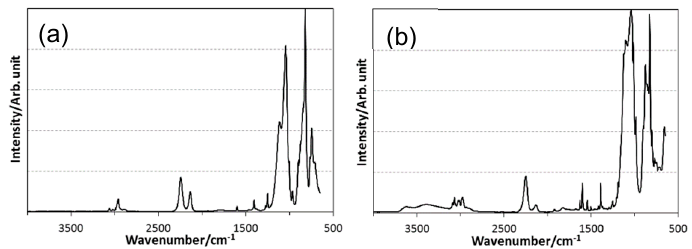
Figure 3. ATR-IR spectra for ( a ) VH-SQ and ( b ) St-H-SQ.